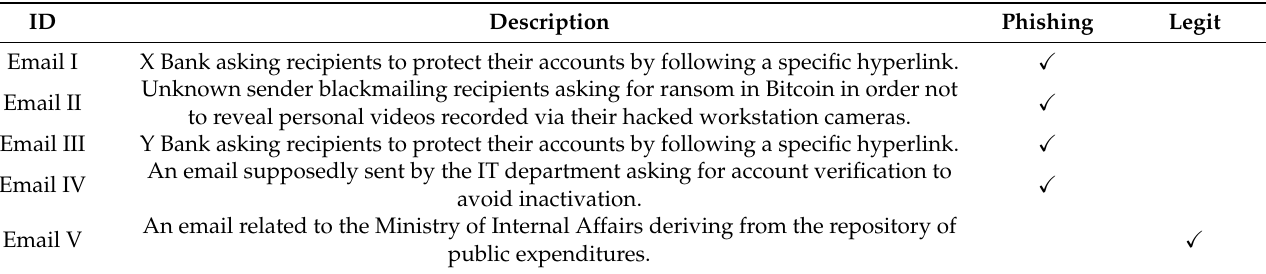
Table 1. Emails Used in The Evaluation Campaign.